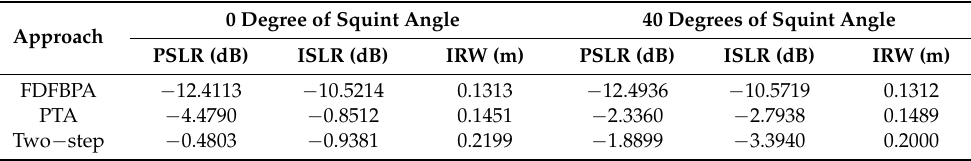
Table 2. Comparison of Quantification Statistics Results.